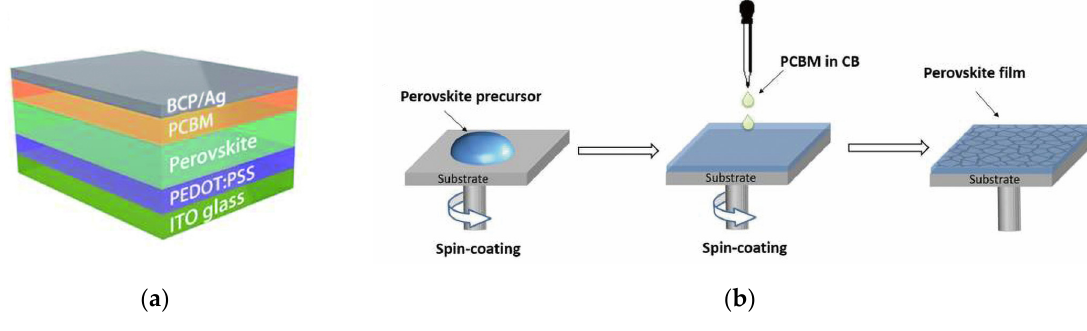
Figure 1. ( a ) Illustration of inverted-type 2D PSC with the configuration of glass/ITO/PEDOT:PSS/perov- skite/PCBM/BCP/Ag. ( b ) Schematic of perovskite deposition process using PCBM-assisted anti-solvent.